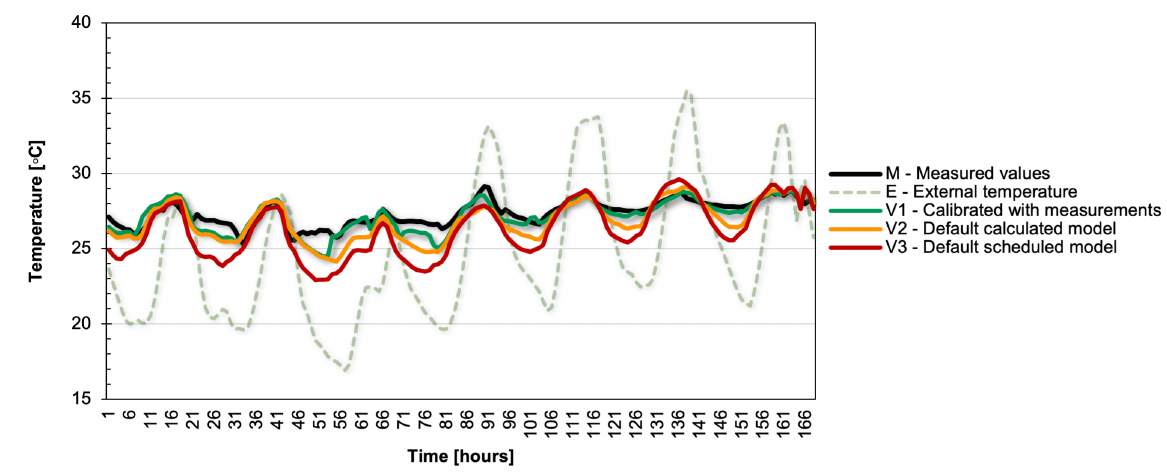
Figure 6. Measured and simulated temperature values in the living room.